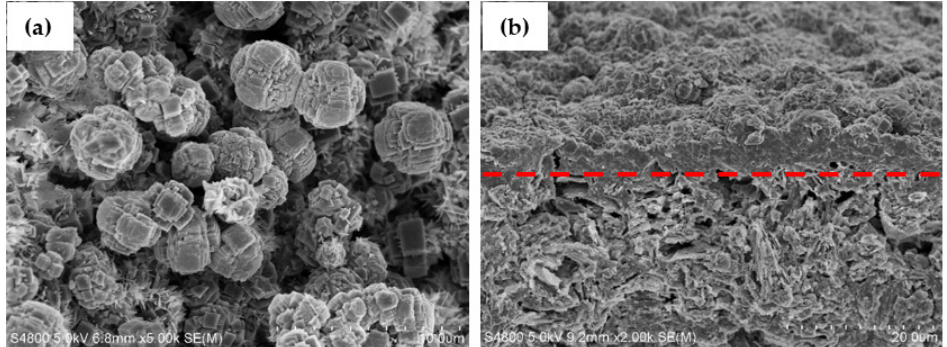
Figure 4. Surface ( a ) and cross-section ( b ) SEM images of KCHA zeolite